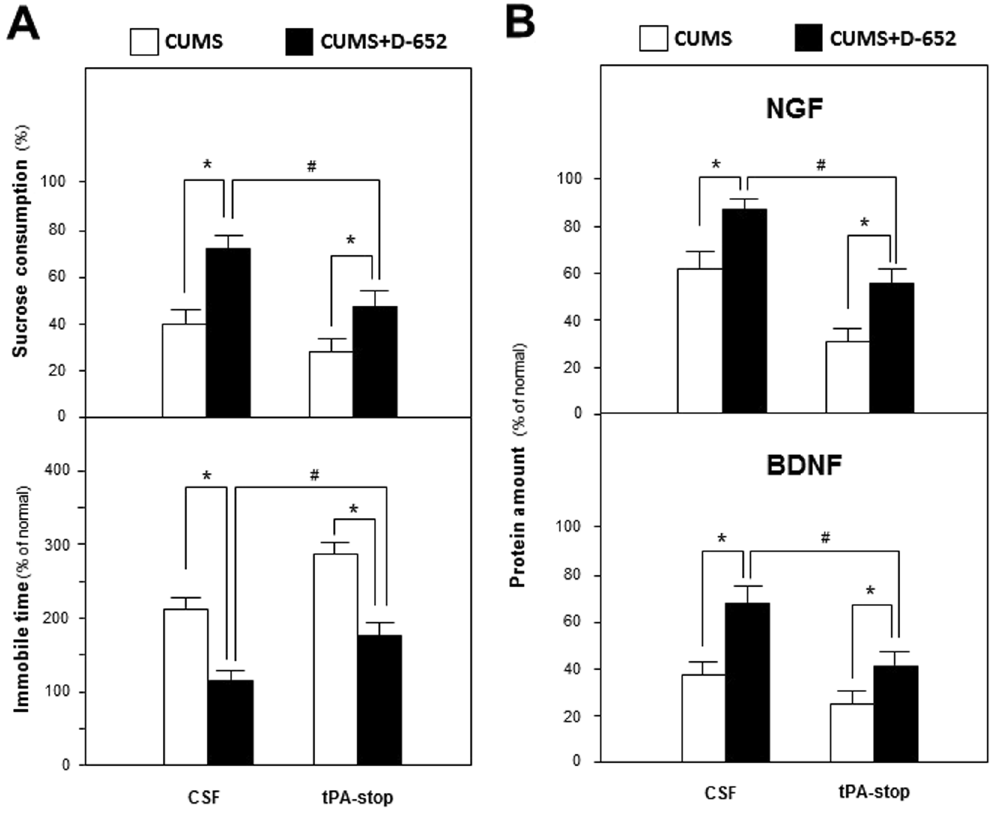
Figure 6. The blocker of tPA attenuates anti-depressive actions of KXS in the behavioral tests and expressions of neurotrophic factors of hippocampus of CUMS-treated mice. ( A ) At the end of CUMS exposures, one group of the mice were treated with D-652 and tPA-stop simultaneously. D-652 was orally treated for 7 days and tPA-stop (dissolved in artificial CSF) was transcranial injected into hippocampus for 3 days. Then, sucrose preference test and forced swimming test were carried out. The CUMS mice only injected with artificial CSF and treated with combination of CSF and D-652 were applied for contrast. ( B ) Amounts of NGF and BDNF were determined in hippocampus of mice as treated in ( A ). Comparisons between groups were carried out by a two-way ANOVA followed by a post-hoc Bonferroni test. Values are expressed in the percentage of non-stressed group as Mean ± SEM (n = 8). # p < 0.05, ## p < 0.01 (comparison between group treated with CUMS/CSF plus D-652 and group treated with CUMS/CSF plus D-652 and tPA-stop); * p < 0.05, ** p < 0.01 (comparison between group treated with CUMS/CSF and group treated with CUMS/CSF plus D-652; comparison between group treated with CUMS/CSF plus tPA-stop and group treated with CUMS/CSF plus D-652 and